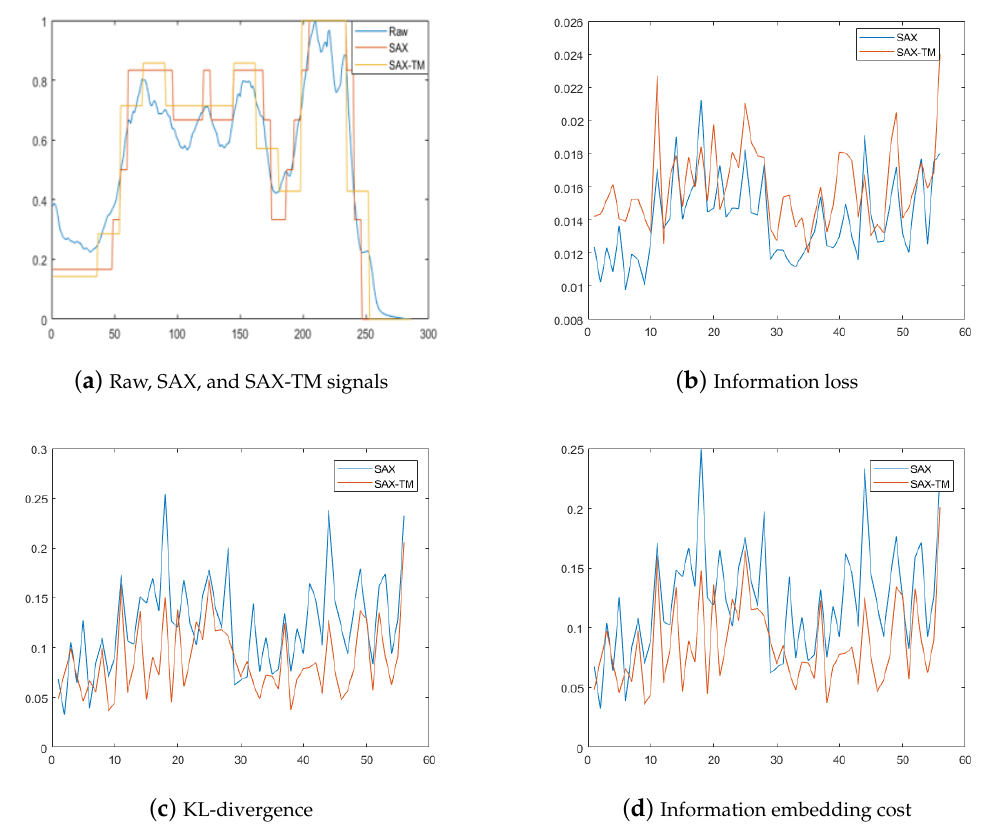
Figure 4. Performance comparison of SAX and the proposed method on the coffee